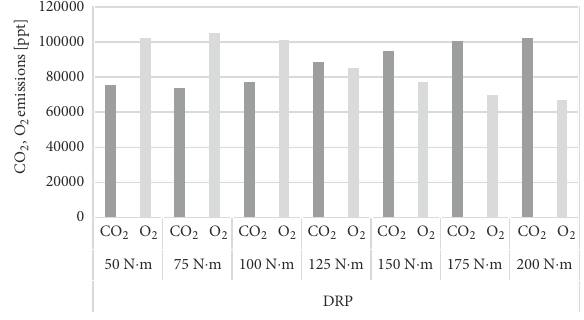
Figure 22. Emission of CO 2 and O 2 for DRP sample with operating parameters of engine 3000 rpm